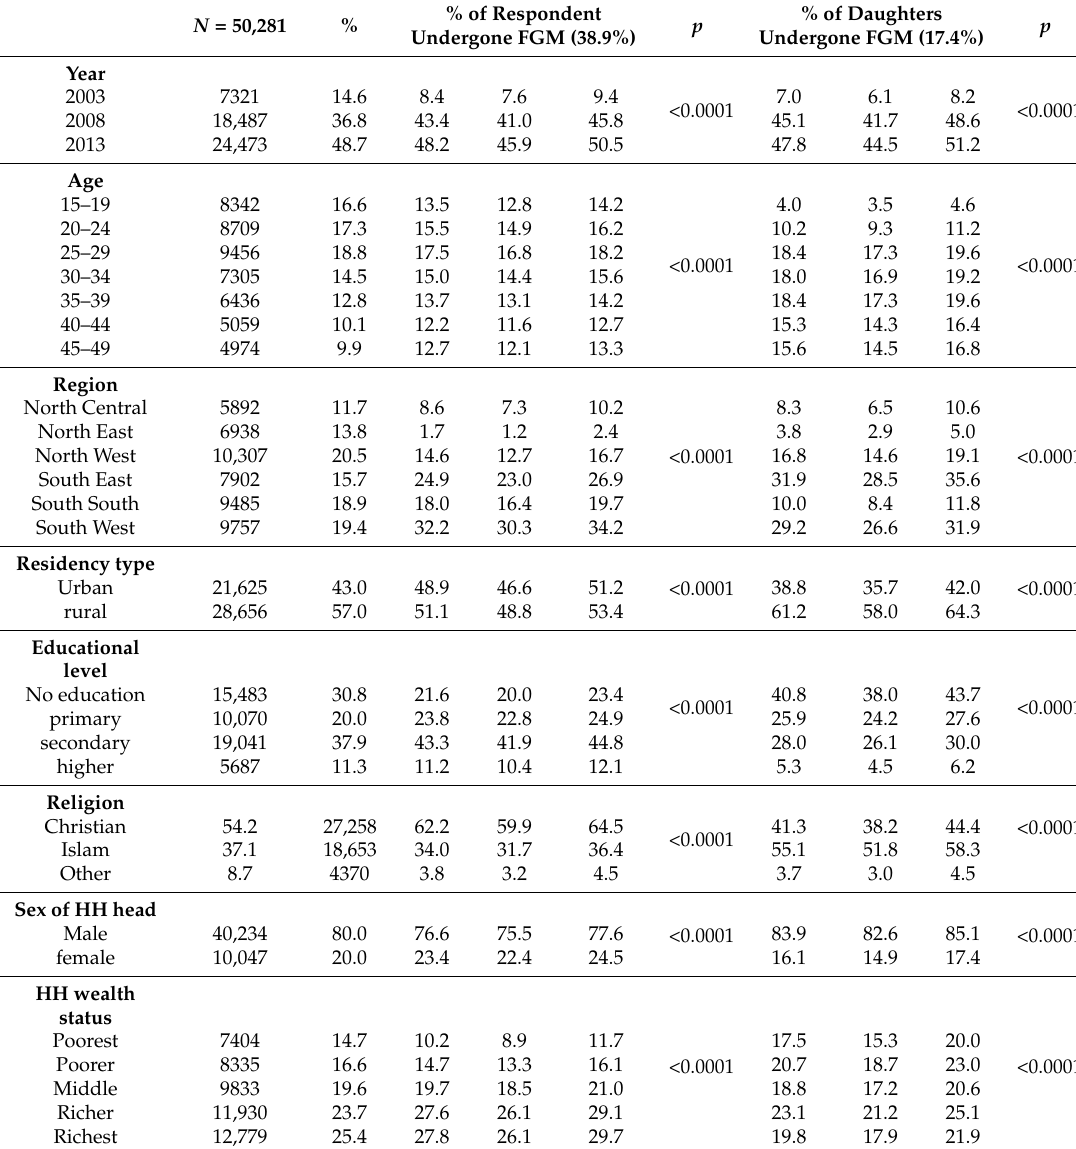
Table A1. Sample characteristics, NDHS